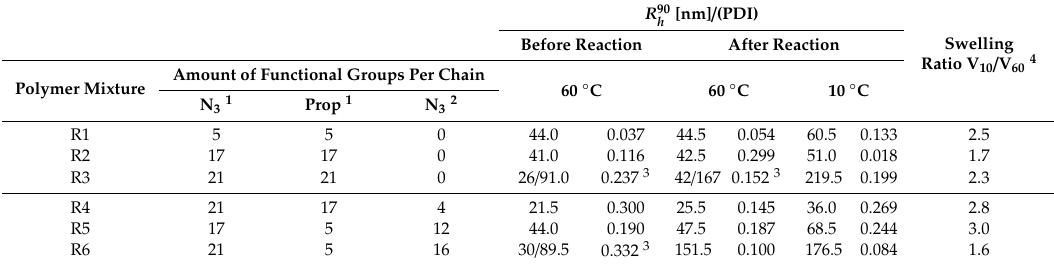
Table 4. Hydrodynamic radii of crosslinked nanoparticles of mixed copolymers at 0.5 g / L (abrupt heating).